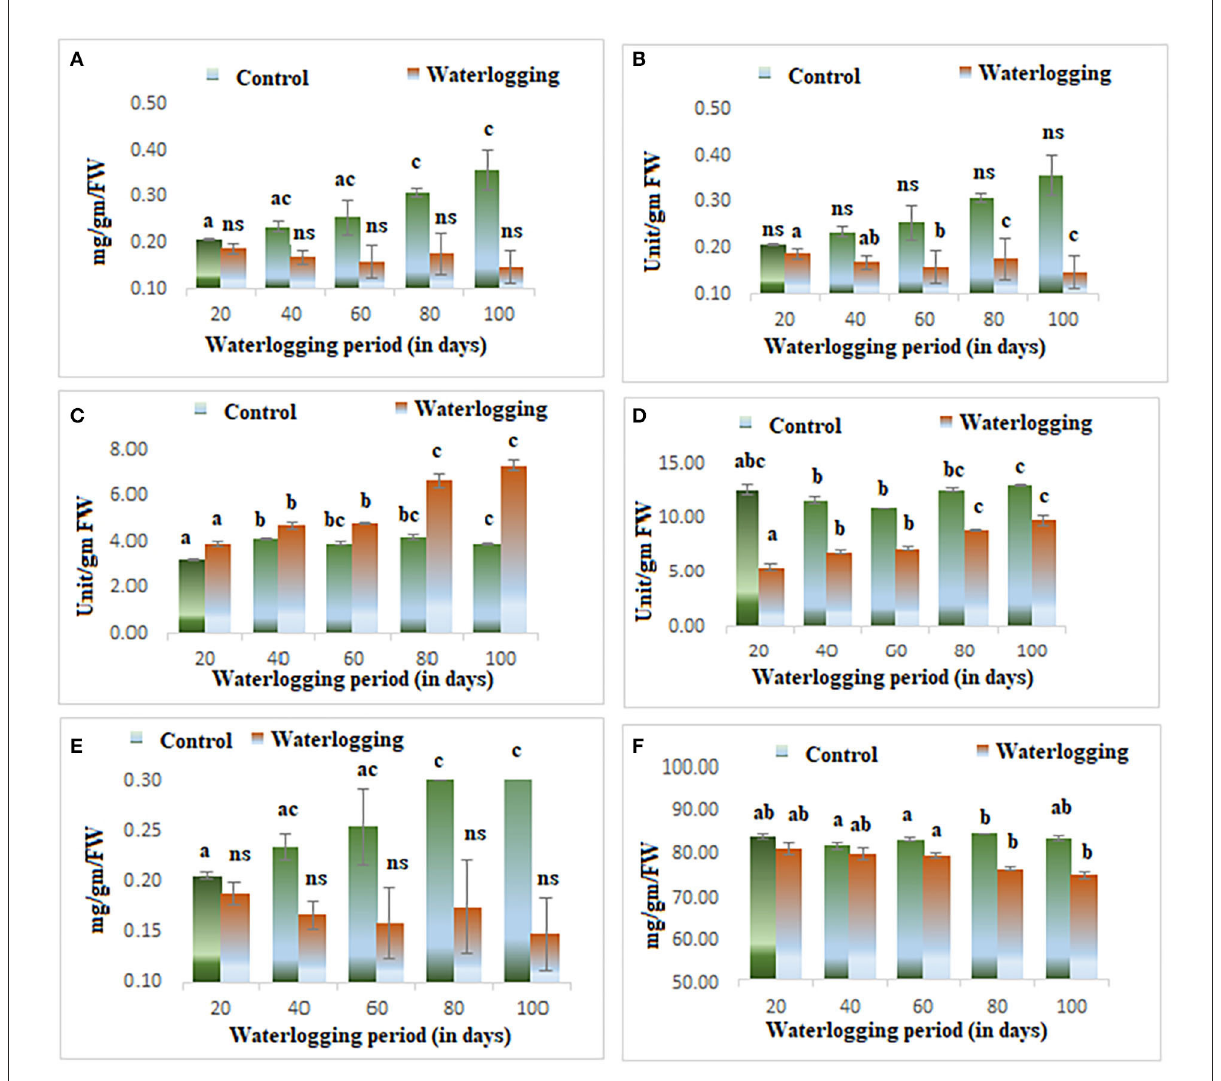
FIGURE2 Biochemical changes in peanuts under different waterlogging treatments (A) Chlorophyll content (B) Activity of superoxide dismutase (C) Catalase activity (D) GPOD activity (E) Soluble sugar content (F) Starch content. The letters are the result of post hoc test.